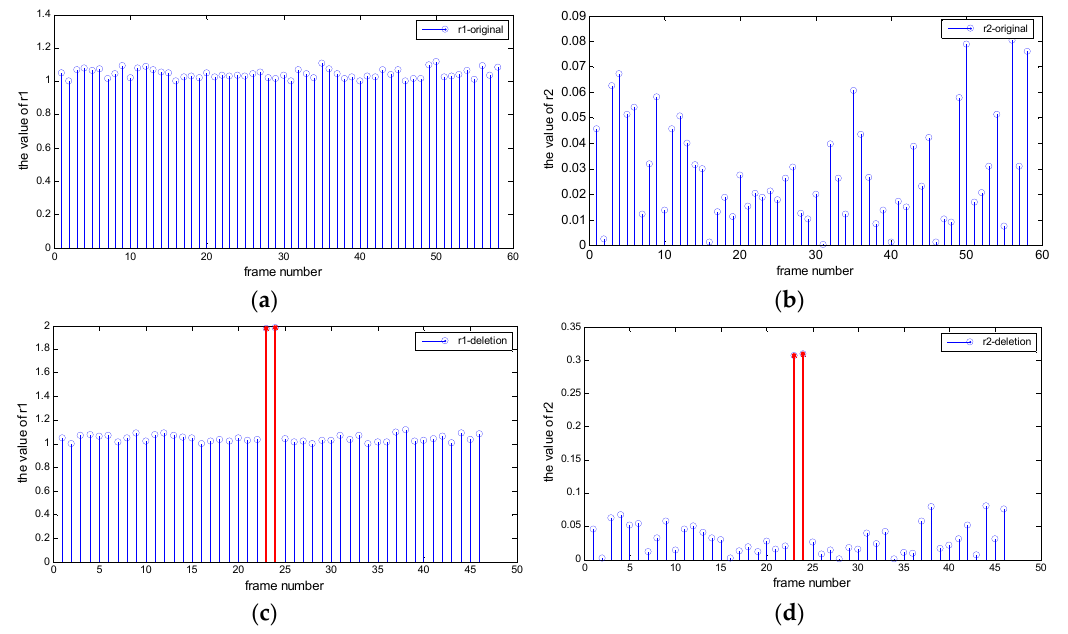
Figure 5. The curve of ∆r1 and ∆r2 . ( a , b ) Original video; ( c , d ) Forged video (frame deletion-15 frames were deleted).